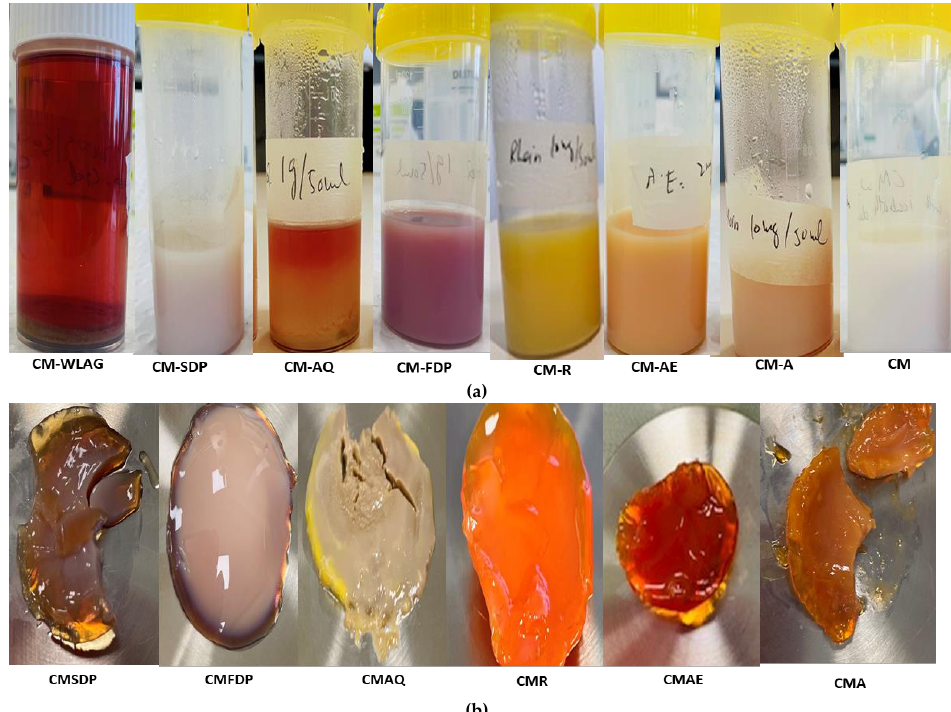
Figure 3. Visual observations of nanocapsules of CM controlled and CM-loaded with aloin (CMA), aloe-emodin (CMAE), rhein (CMR) and CM-loaded with freeze-dried powder (CMFDP), anthraquinones powder (CMAQ), spray dried powder (CMSDP) and whole leaf Aloe vera gel (CMWLAG) before centrifugation ( a ) and pallets of casein micelles nanocapsules after centrifugation ( b ).